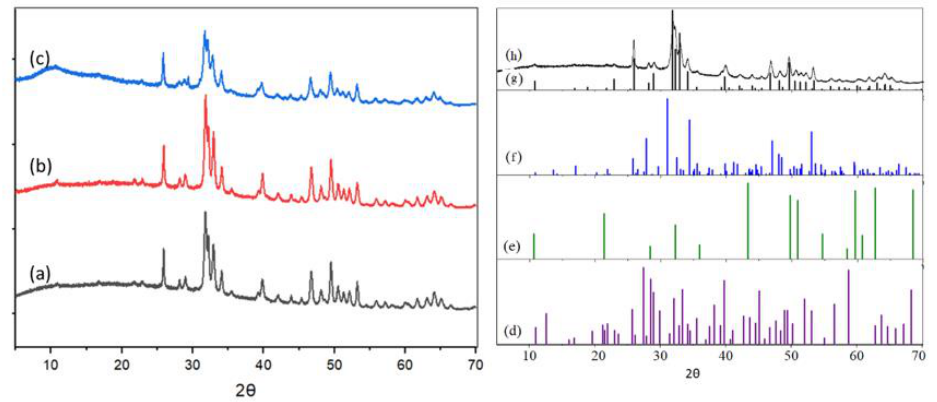
Figure 4. XRD diffractograms of ( a ) HAp-D, ( b ) HAp-S and ( c ) HAp-R ( left ); and the standard PDF cards for ( d ) HAp-S, ( e ) calcium hydroxyapatite, ( f ) β -TCP, ( g ) OCP and ( h ) DCP ( right ) . Moreover, no peak was assigned to β -tricalcium phosphate ( β -TCP) (PDF 00-055- 0898); octacalcium phosphate (OCP) (PDF 00-044-0778), nor to calcium pyrophosphate (DCP) (PDF 00-044-0762) were observed (Figure 4 right). In addition, for HAp-R, no other crystalline phase, namely CaO with 2 θ at 32.2 ◦ , 37.4 ◦ and 53.9 ◦ (PDF 01-070-4066) or Ca hydroxide with 2 θ at 18.14 ◦ , 28.7 ◦ , 34.2 ◦ , or 50.8 ◦ (PDF-00-087-0673) were observed. However, it has to be noted that the main XRD peak for CaO at 2 θ = 32.2 ◦ or Ca(OH) 2 at 34.2 ◦ , could be hidden by intense peaks of HAp-R between 2 θ = 31 ◦ and 35 ◦.